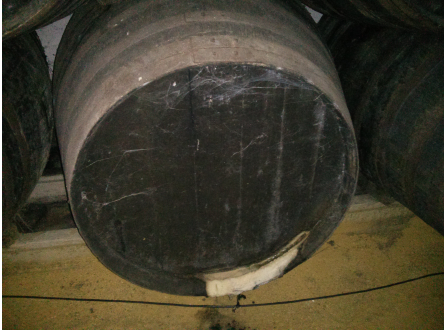
Figure 3. Wine loss due to a crack in a cask.